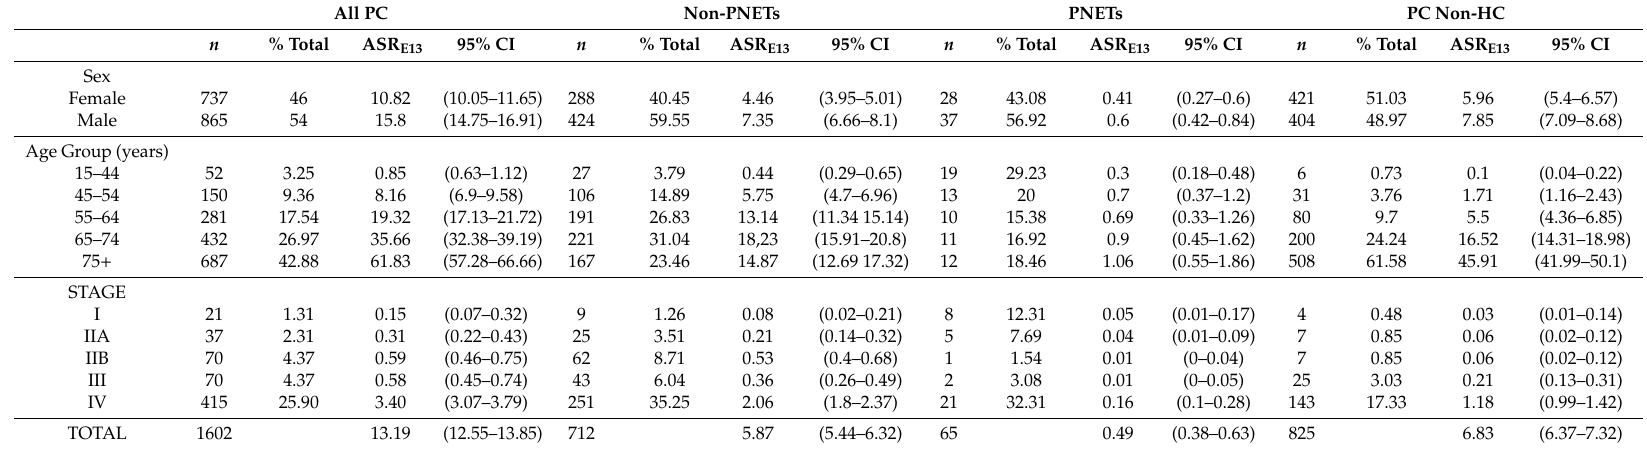
Table 2. Incidence of pancreatic cancer (PC) in Girona, 1994–2015. European standard population of 2013 (ASRE13) according to histology. Non-PNET—Pancreatic carcinomas non-neuroendocrine. PNET—Pancreatic neuroendocrine tumours. Non-HC—Pancreatic cancers non-histologically